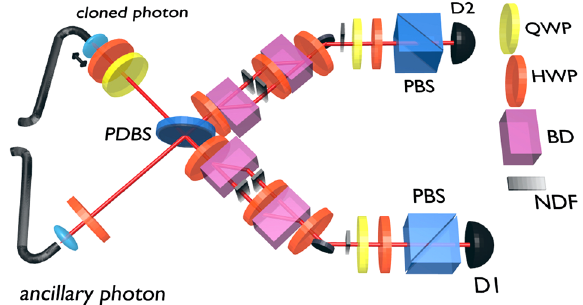
Fig. 3 Experimental setup for cloning quantum bankotes. Compo- nents are labeled as follows: HWP is half-wave plate, QWP is quarter wave-plate, PDBS is polarization dependent-beam splitter, PBS is polarizing beam splitter, BD is beam divider, NDF is neutral density fi lter, and D is single photon detector. A successful cloning and veri fi cation of a qubit from a given sequence is registered as a simultaneous detection event at the two